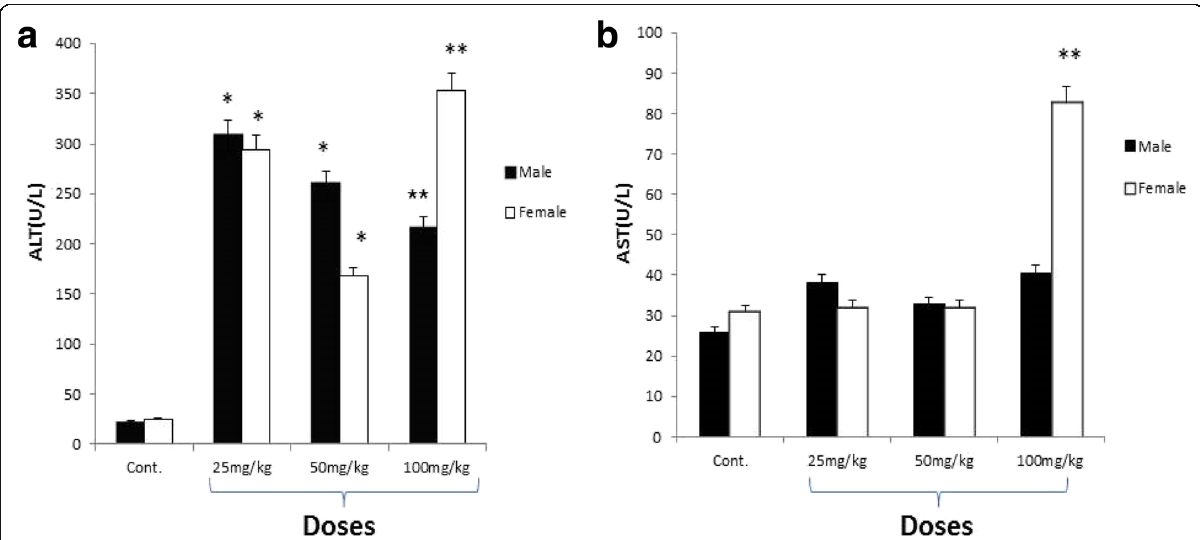
Fig. 1 a and b Values of treated groups with respect to control are significantly differing at: * P < 0.05, ** P <